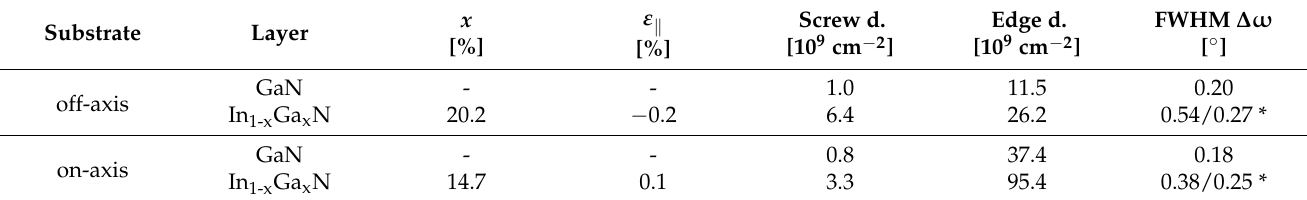
Table 1. Ga molar ratio x in In 1-x Ga x N, residual strain ε ll in In(Ga)N, density of screw and edge dislocations and FWHMs of 0002 rocking curves ( ω -scans) calculated from the XRD measurements.